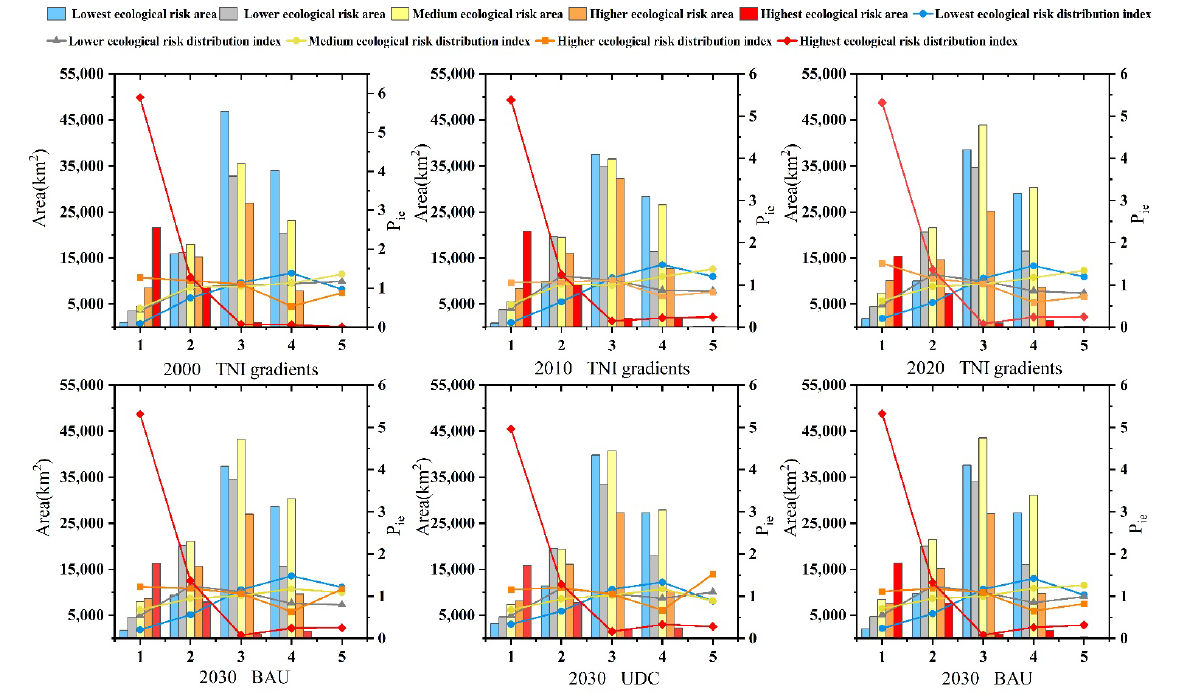
Figure 7. Area and gradient distribution index of each level of ecological risk.